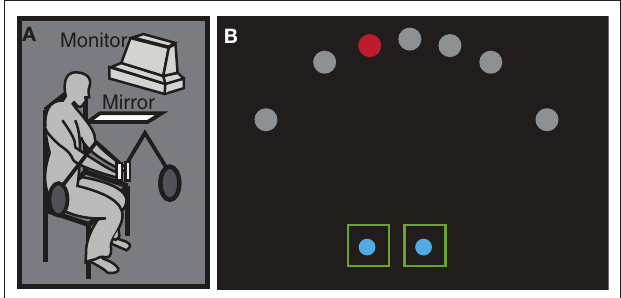
Figure 1 | (A) A computer monitor projected stimuli onto a mirror, creating the impression that the stimuli were in the same plane as the participant’s hands. The robotic device restricted movement to this plane. (B) Stimuli appeared in one of seven locations in Experiment 1 (shown here) and one of nine locations in Experiment 2. While the visible size of the targets remained constant, a staircase algorithm adjusted the radius of a virtual target region that was used to achieve a specified reward